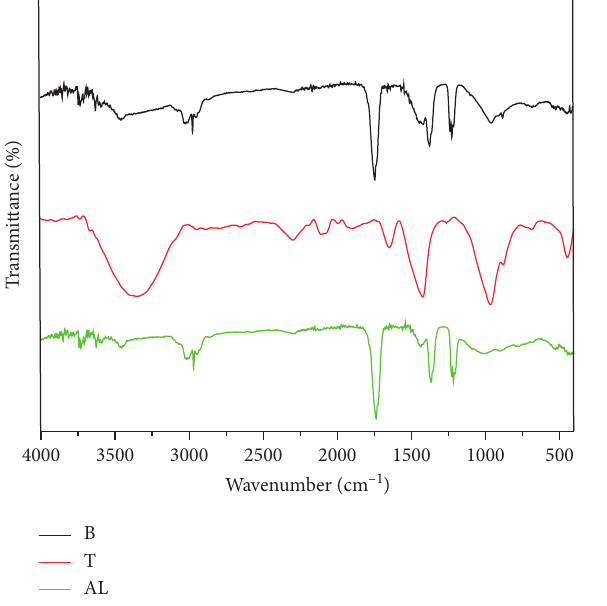
Figure 8: FT-IR image of 2.5 M and 1 :2 of SH: SS.